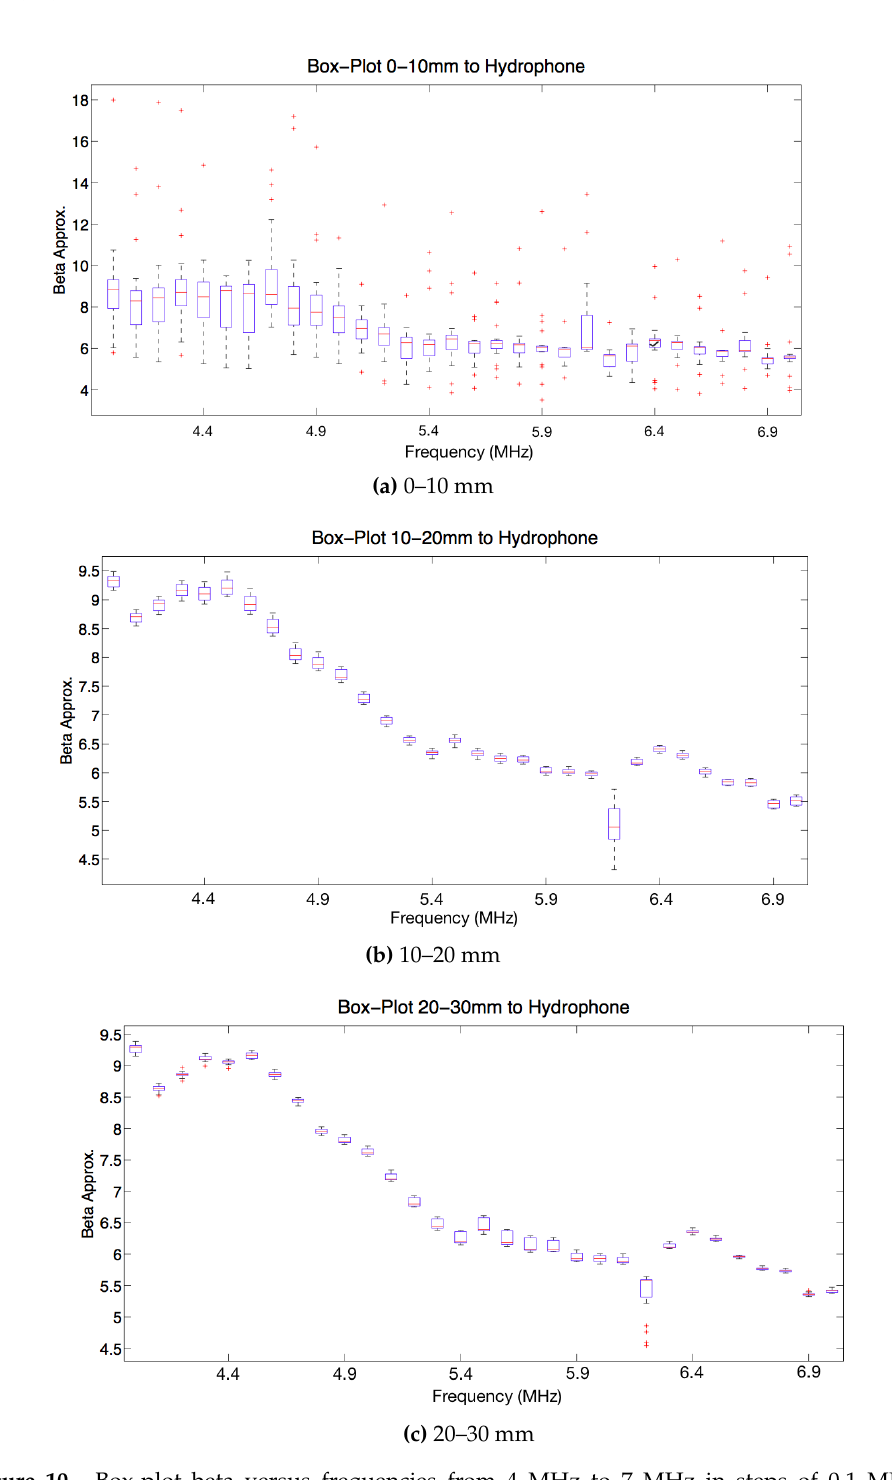
Figure 10. Box-plot beta versus frequencies from 4 MHz to 7 MHz in steps of 0.1 MHz and using 50 cycles. Mean and standard deviation values are computed considering different distances specimen-hydrophone: in ( a ) distance 0–10 mm, in ( b ) distance 10–20 mm and in ( c ) distance 20–30